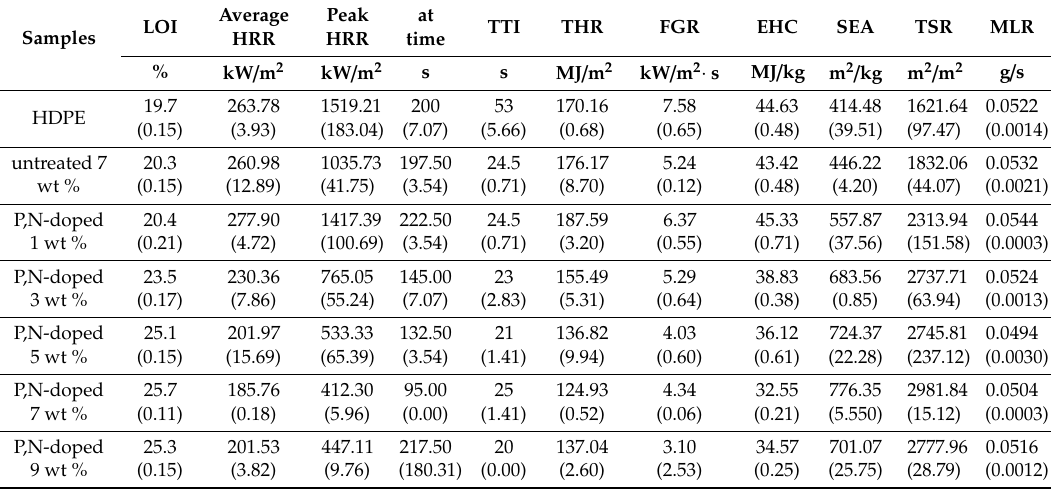
Table 1. Cone calorimeter and LOI results of HDPE composites with P,N-doped cellulose.